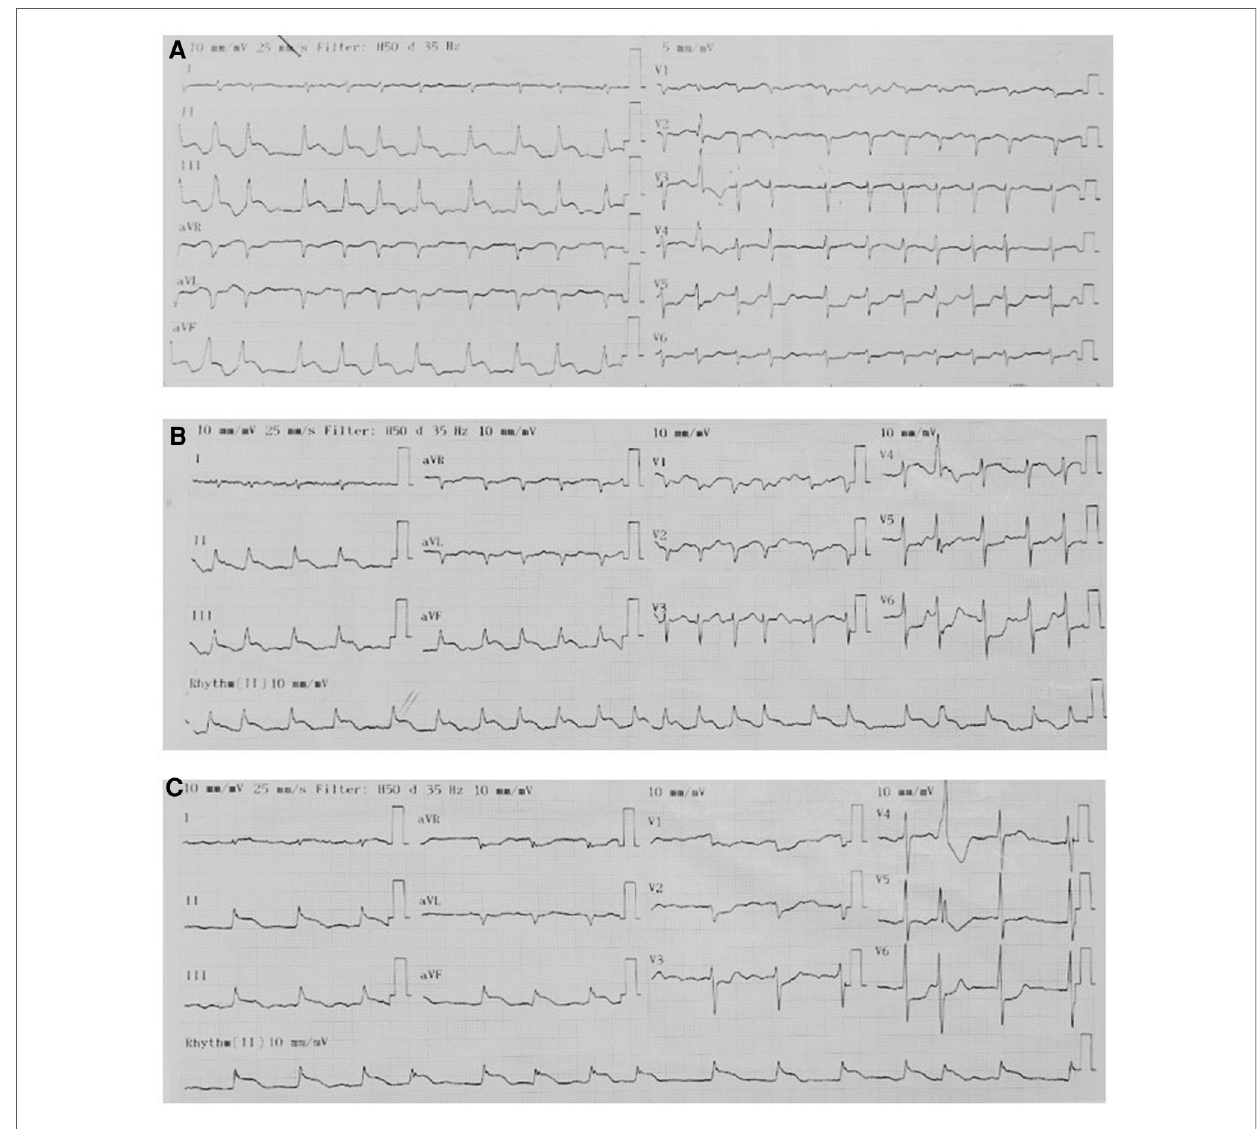
FIGURE 1 Serial ECGs. The pattern of ECGs was persistent, including atrial fi brillation, right axis deviation, poor R-wave progression, profound STE in leads II, III, and aVF with the presence of reciprocal ST depression in the precordial leads. ( A) On admission. ( B) 1 h later. ( C) Before